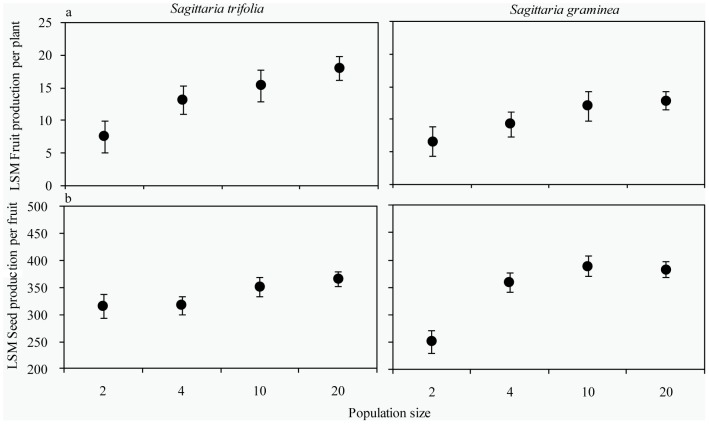
Reproductive success of S. trifolia and S. graminea.(a) Least-square means (LSM) for total fruit production per plant, (b) LSM for seed production per fruit in populations of different sizes. Bars represent confidence limits to 95%.